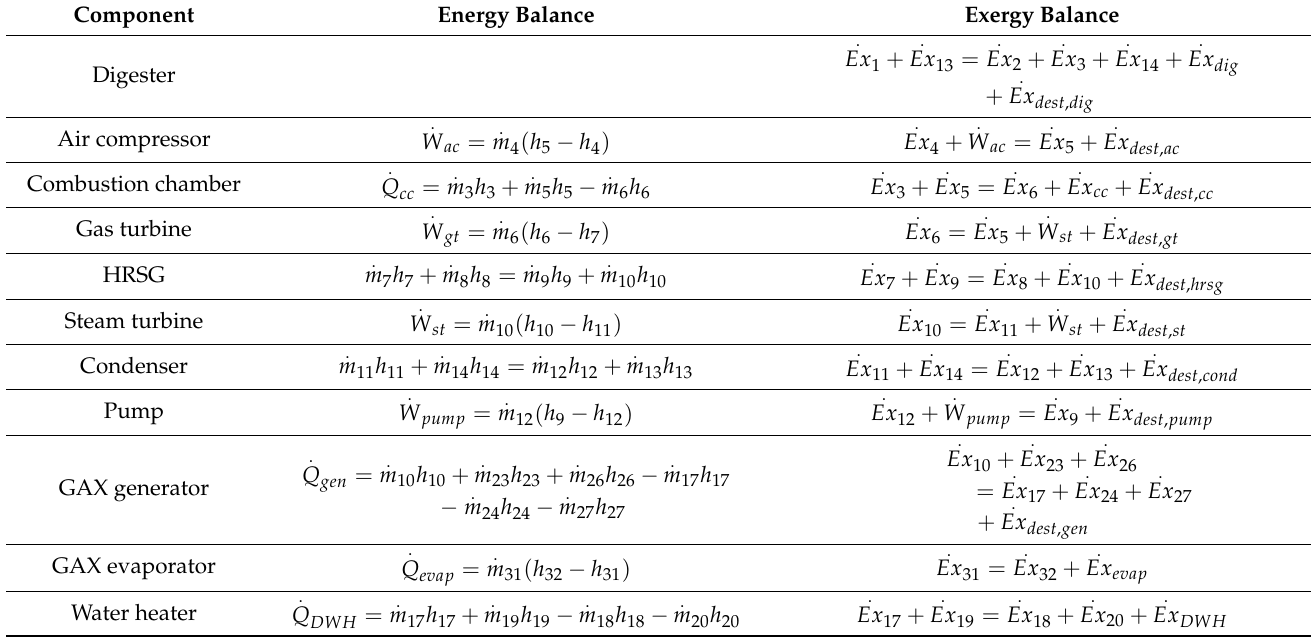
Table 3. Energy and exergy balance equations of the components of the CHP system